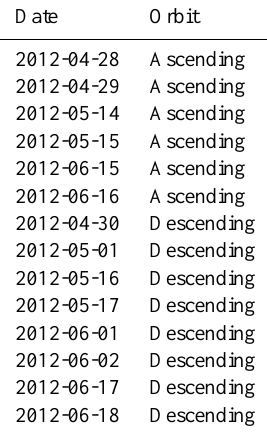
Table 1. COSMO-SkyMed available